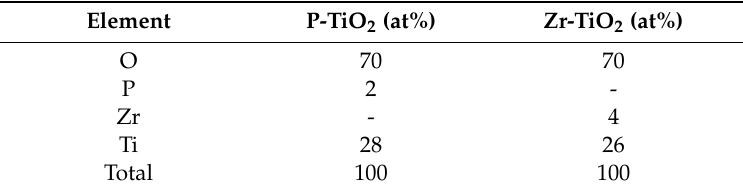
100 100 All the atomic percentages are the average on three di ff erent areas. All the atomic percentages are the average on three different areas.